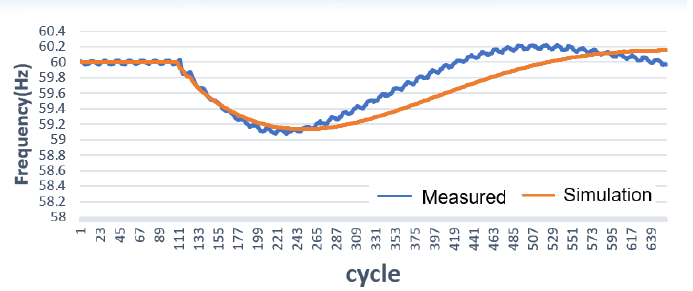
Figure 6. Frequency response simulation (PSSE) of ESS2 and ESS3 to a N-1 contingency and as meas- ured from PMU.